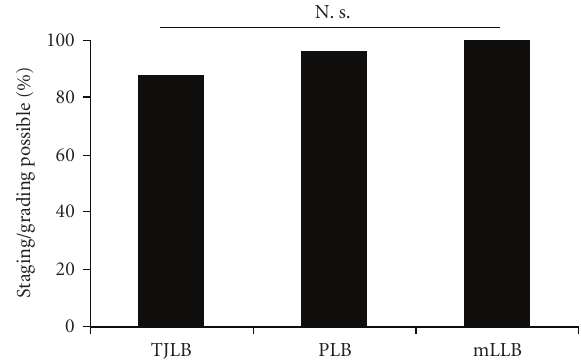
Figure 4: Staging/grading in chronic hepatitis . No statistically significant di ff erence in the rate of staging/grading for chronic hepatitis was detected between the three